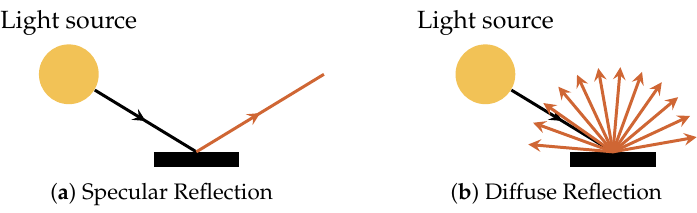
Figure 2. Illustration of specular and diffuse